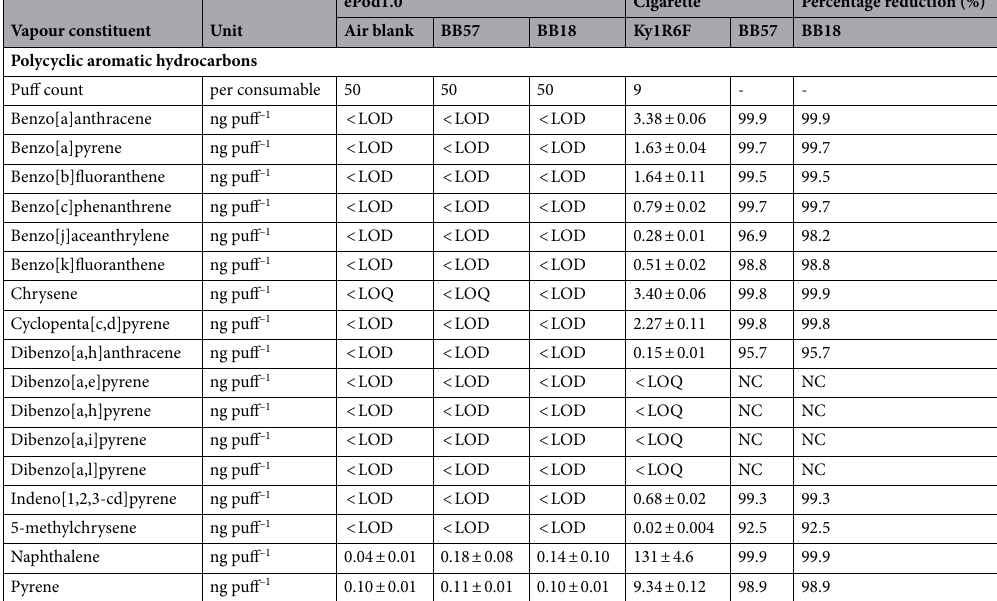
Table 2. Polycyclic aromatic hydrocarbons: Per-puff concentration of e-cigarette vapour emissions, respective method air blanks and Ky1R6F cigarette smoke. Values are presented as mean ± standard deviation (n = 5). Percentage reduction of e-cigarette emissions relative to Ky1R6F cigarette smoke. NC not calculated, LOD limit of detection, LOQ limit of quantification. More information about the analytical methods and respective LODs and LOQs are under the Supplementary Information (Tables S1 and